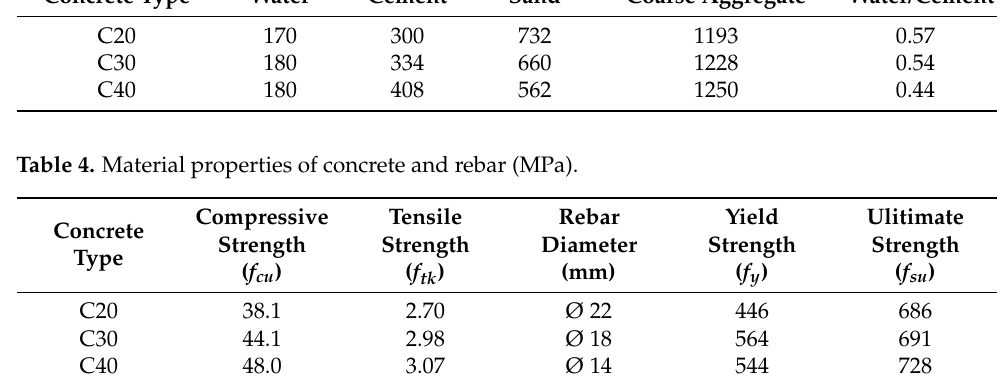
Table 5. Properties of the beams (mm).